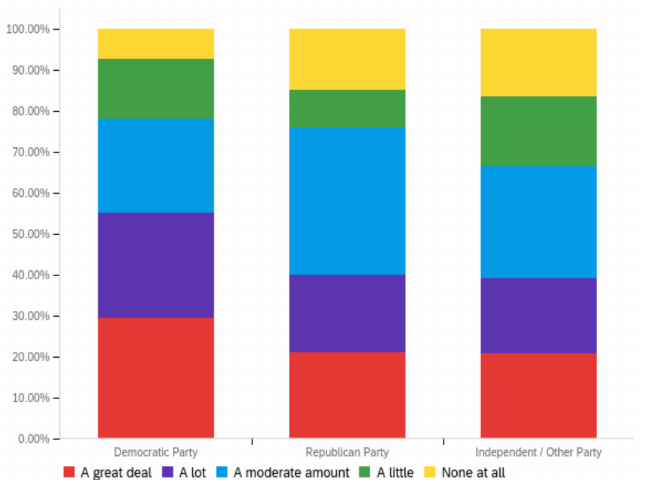
Figure 4. Article sponsor—personal perception impact by political affiliation.